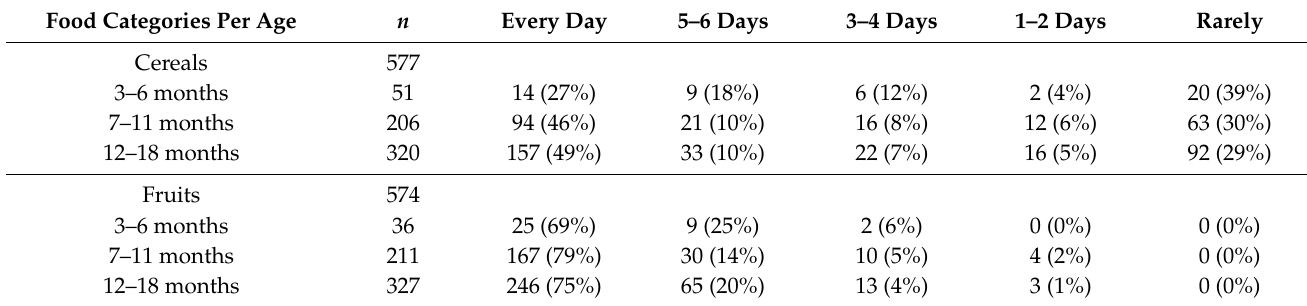
Table 2. Frequency of intake of solid foods per week per age group. Percentages are calculated from the sample that was introduced to the corresponding food category. To specify rarely means a consumption with a lower frequency than 1 time per week.